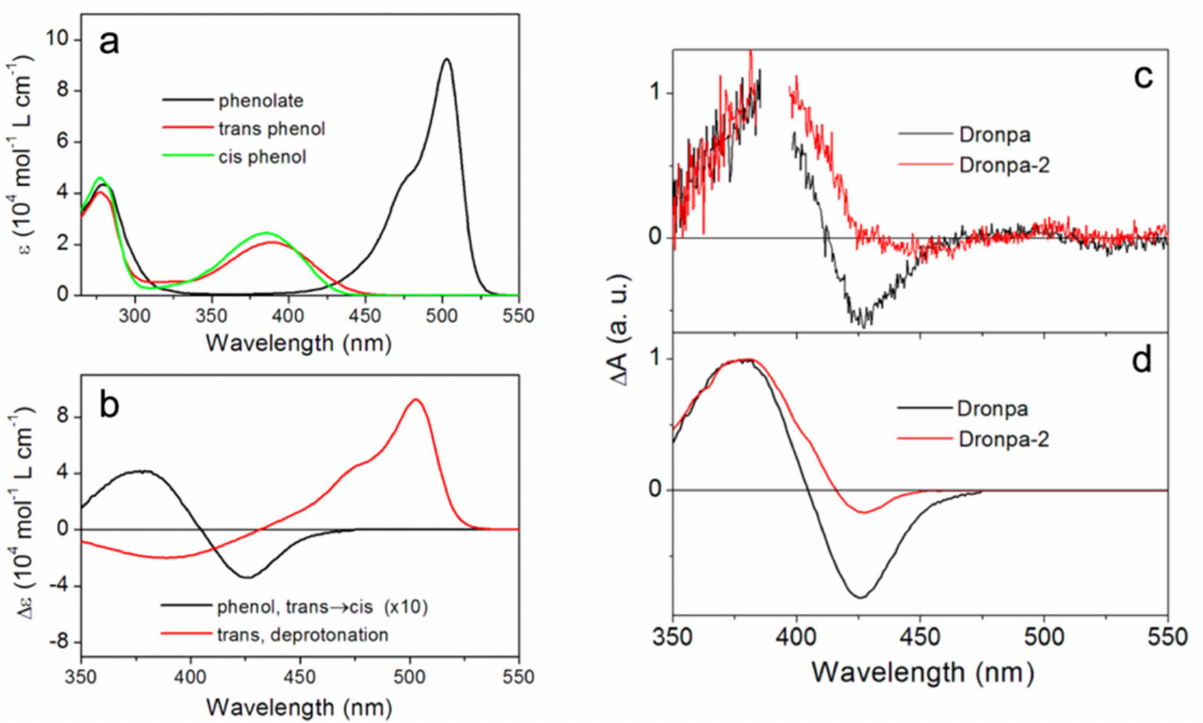
Figure 3. Characteristic electronic features of Dronpa and Dronpa-2. ( a ) Steady-state absorption spectra of Dronpa in the cis -phenolate (black), trans -phenol (red), and cis -phenol (green) forms. ( b ) Difference spectra of the cis -phenol minus trans -phenol form (black; an isomerization event) and the trans -phenolate minus trans -phenol form (red; a deprotonation event). ( c ) Decay-associated difference spectra (DADS) of the long-lived (ns) species of Dronpa (black) and Dronpa-2 (red) from global analysis of the transient absorption data. ( d ) The smoothed steady-state difference spectra of the chromophore’s phenol forms ( cis minus trans ) in Dronpa (black) and Dronpa-2 (red). Reprinted with permission from Ref. [59]. Copyright 2014 American Chemical